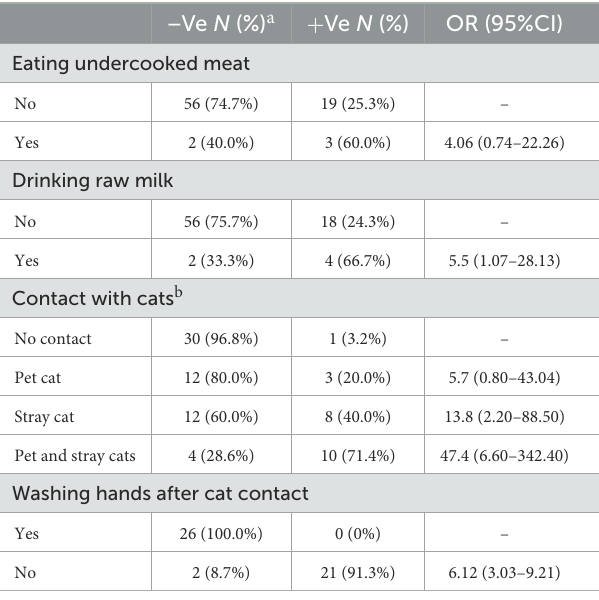
TABLE 2 A summary of hygienic practices and contact with cats, univariable firth logistic regression model.